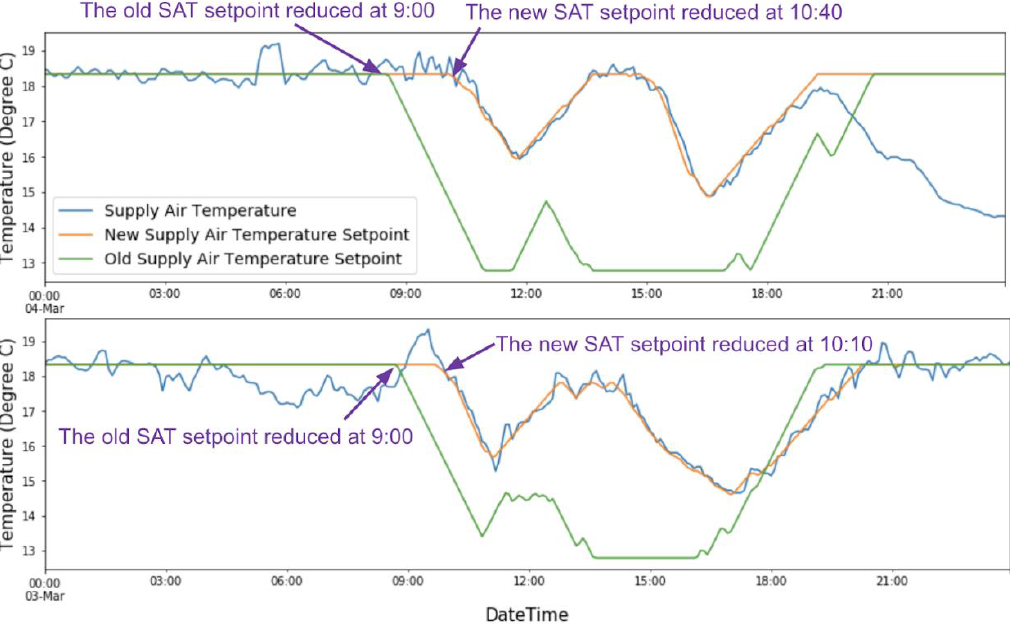
Figure 8. Comparison of the new and the old setpoint control strategies in AHU01 during March 3 and 4